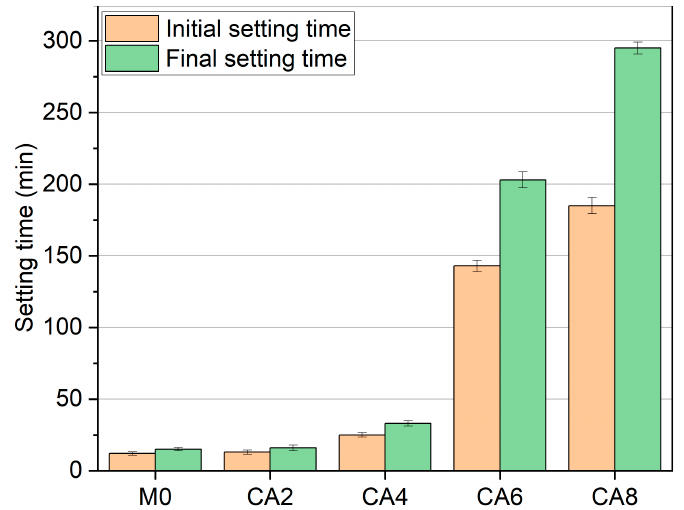
Figure 4. E ff ect of citric acid on se tt ing time of AAS with di ff erent dosages. Figure 4. Effect of citric acid on setting time of AAS with different